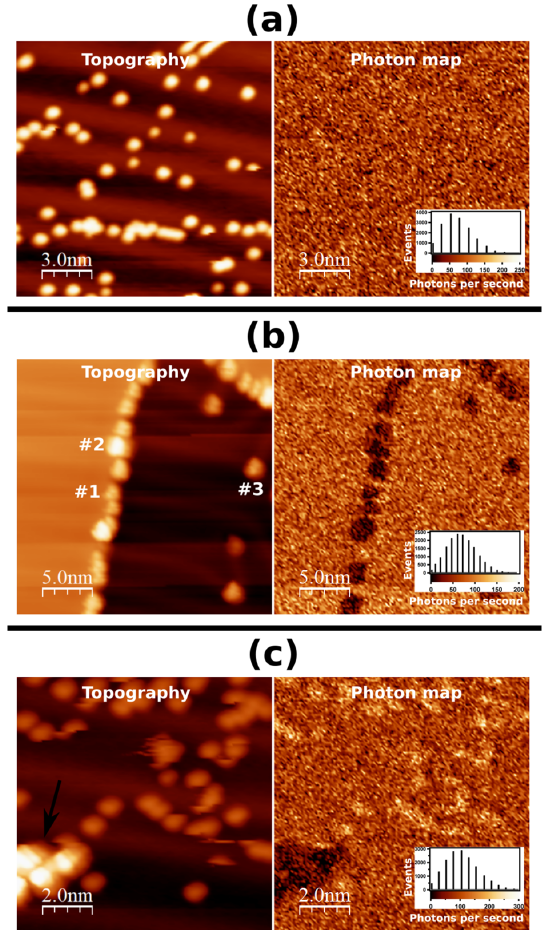
Figure 2. ( a ) STM topographic image and simultaneously acquired photon integration map of isolated (M)-[7]TH-diol molecules adsorbed on the Au(111) surface ( − 3.5 V, 500 pA, 128 × 128 pixels, 39 ms/pixel). (right column) The photon emission per second taken at each pixel of the photon integration map was used to obtain the histogram. The histogram shows a weak emission of about 50 photons per second. ( b ) STM topographic image and simultaneously acquired photon integration map of clusters of (M)-[7]TH-diol molecules preferentially adsorbed at the step edges of Au(111) terraces ( − 3.0 V, 250 pA, 128 × 128 pixels, 7.8 ms/pixel). (right column) The histogram shows a weak emission of about 60 photons per second. ( c ) STM topographic image and simultaneously acquired photon integration map of isolated (M)-[7]TH-diol molecules adsorbed on Au(111) surface ( − 3.0 V, 500 pA, 128 × 128 pixels, 39 ms/pixel), in which meaningful enhancement of light emission on the clusters are observed. (right column) The histogram shows emission of 100 photons per second.